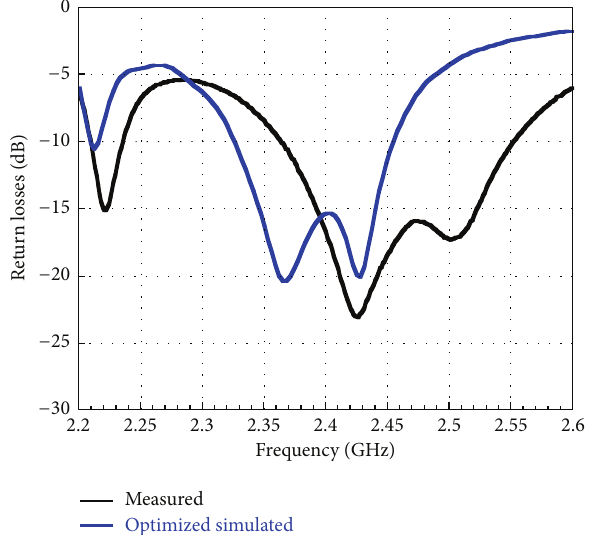
Figure 18: Measured return losses (CRA with softened edges).